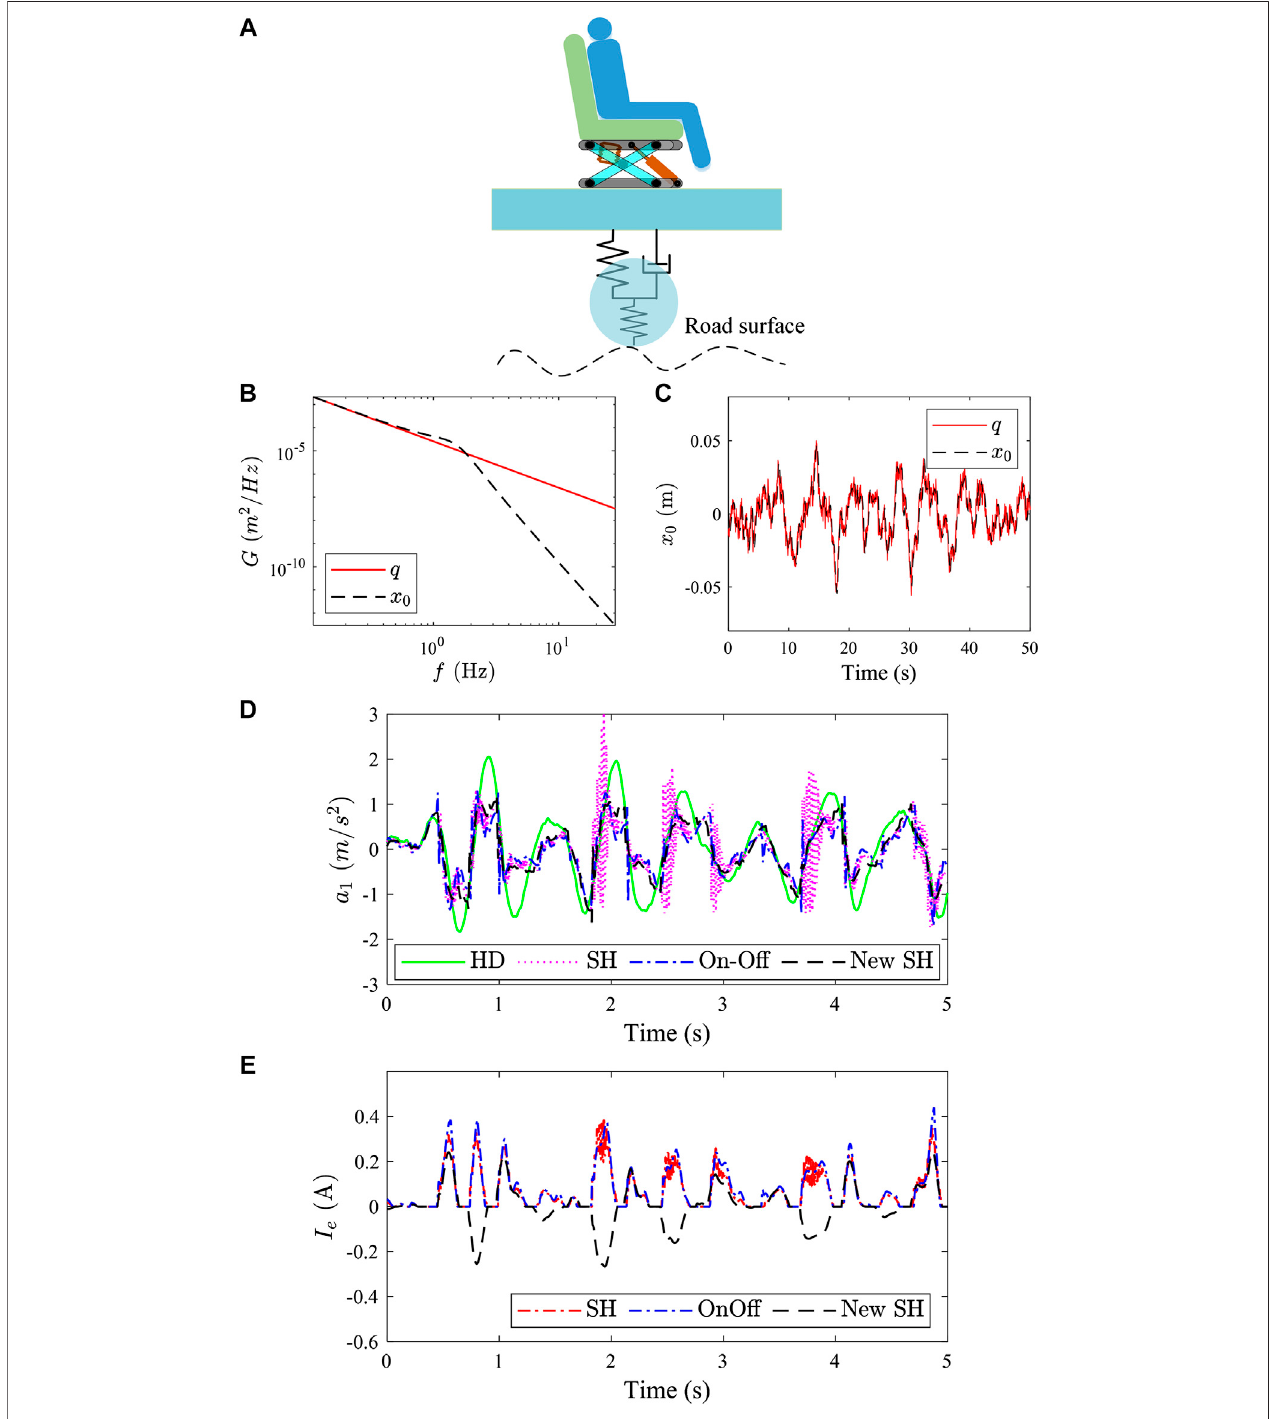
FIGURE 9 | Random input for seat suspension ( v (cid:2) 10m / s, road C): (A) schematic diagram of seat excitation; (B) displacement excitation PSD curve, (C) displacement excitation time-domain curve, (D) simulation results of seat suspension under random displacement excitation; and (E) expected current of the MR damper under random displacement